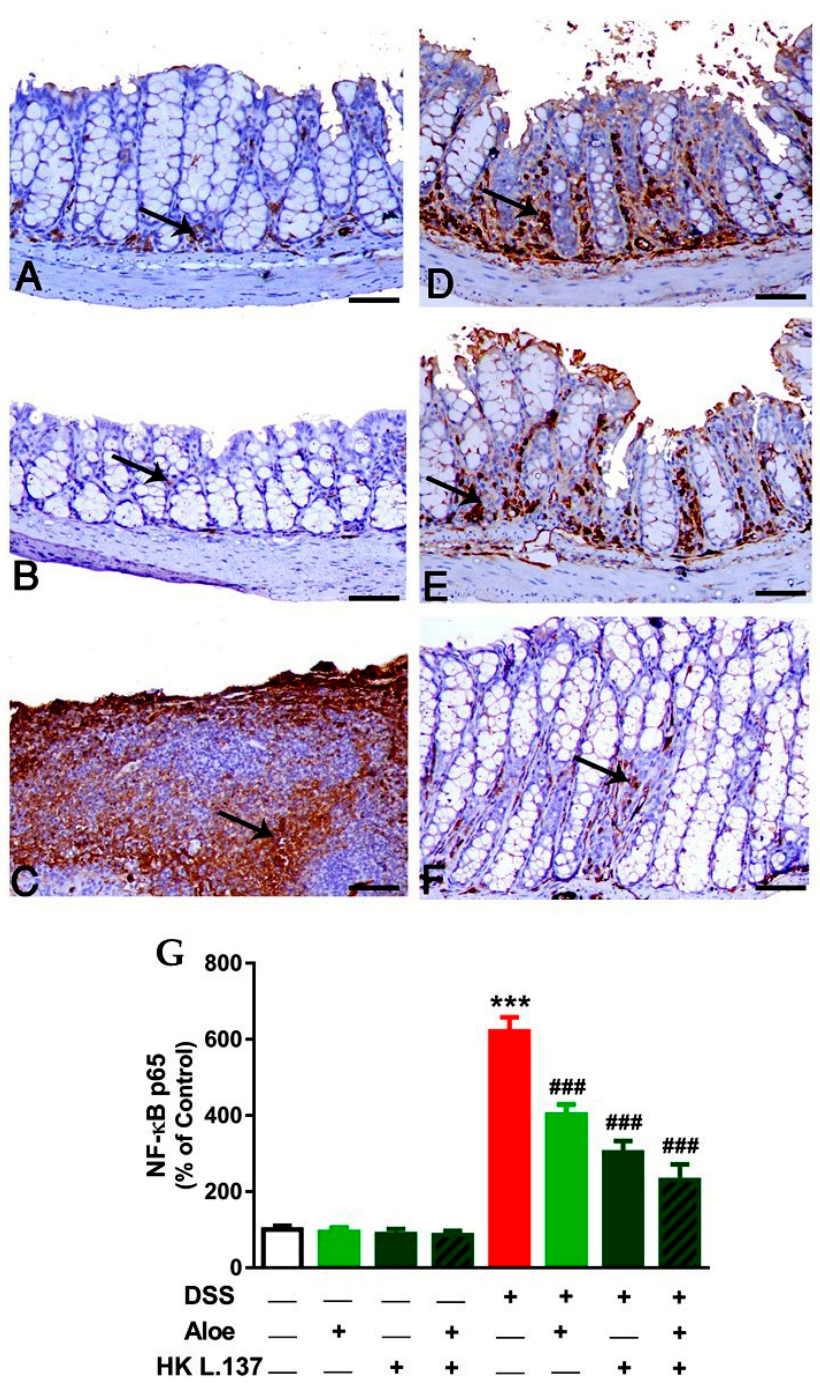
Figure 4. Aloe and/or HK L.137 attenuate NF- κ B p65 expression in the colon of DSS-induced mice. NF- κ B p65 immunostained colon sections from ( A ) Control and ( B ) Aloe/HK L.137-treated mice showing mild interstitial expression, ( C ) DSS-induced mice revealing upregulation of NF- κ B p65 mostly within the infiltrated inflammatory cells, and ( D – F ) DSS-induced mice treated with Aloe ( D ), HK L.137 ( E ), and their combination ( F ) showing markedly reduced expression of NF- κ B p65. Arrows indicate positive immunostaining. ( G ) Mean ± SD of the NF- κ B p65 expression in colon of di ff erent groups. *** p < 0.001 versus Control and ### p < 0.001 versus DSS. (Scale bar = 50 µ